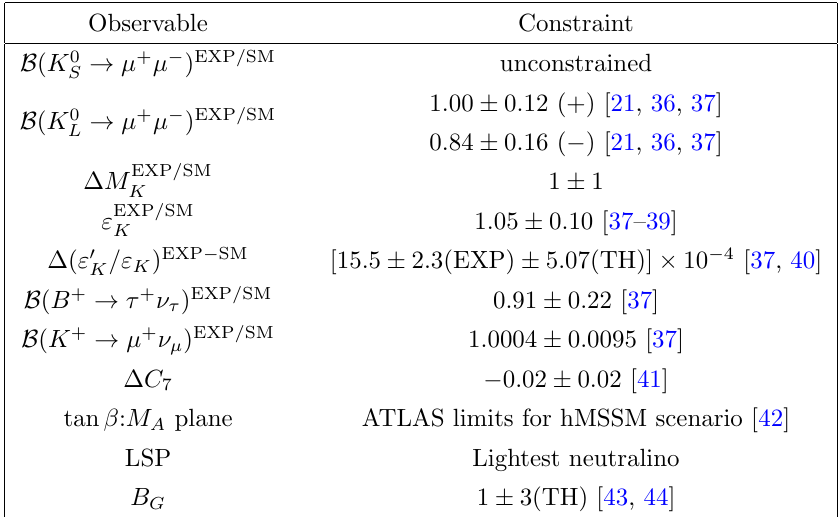
Table 1 . Physics observables constraints imposed in this study. The two di(cid:11)erent constraints on B ( K 0 ! (cid:22) + (cid:22) (cid:0) ) EXP = SM arise from an unknown sign of A (cid:22) L